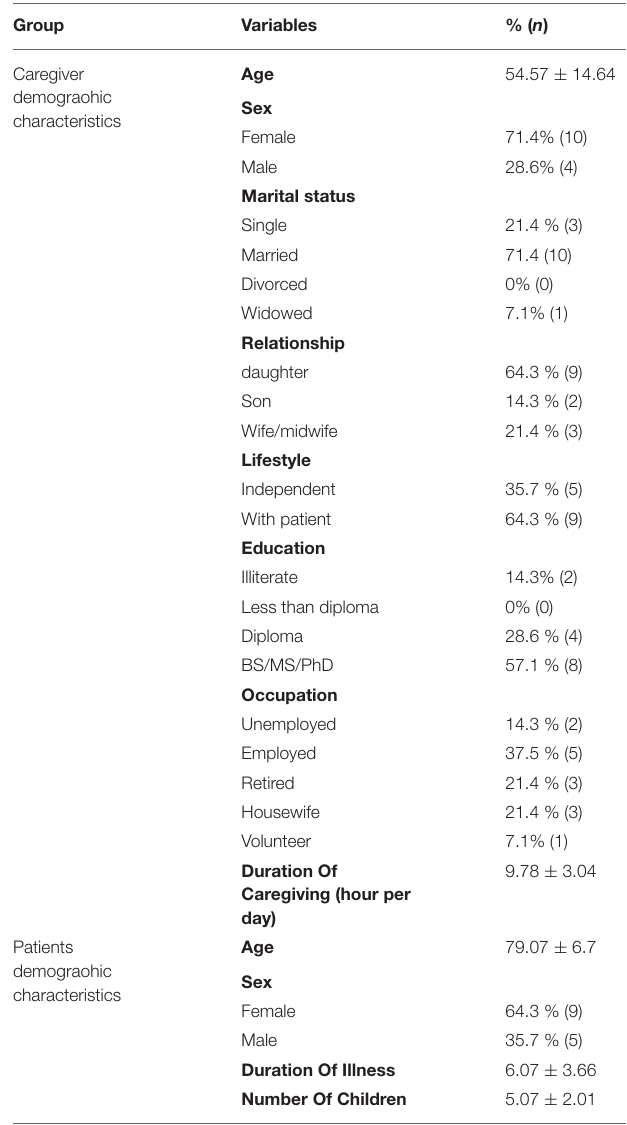
Patients demograohic characteristics